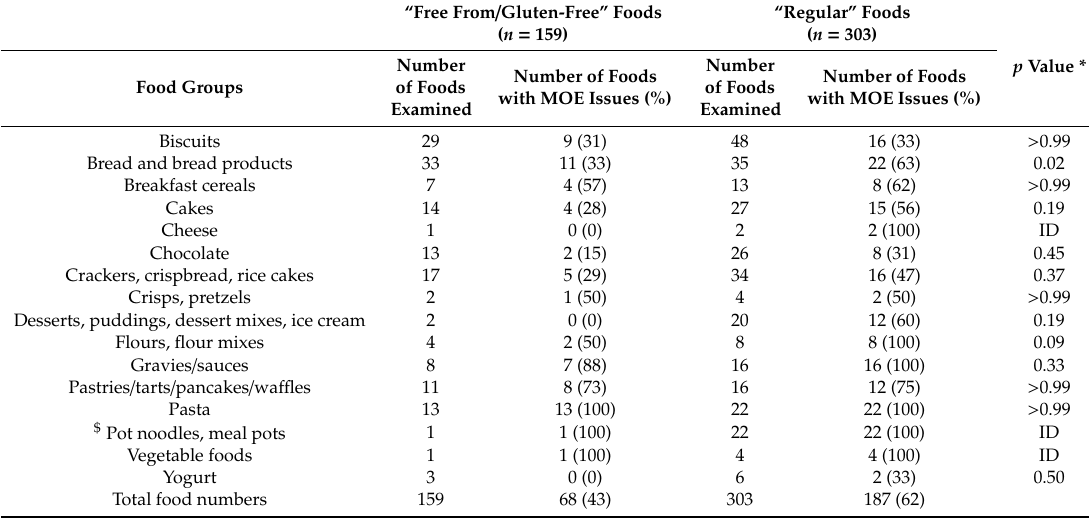
Table 1. Number of individual foods with misleading, omitted, or erroneous (MOE) information that would a ff ect the protein content calculation from information given on the supermarket websites.